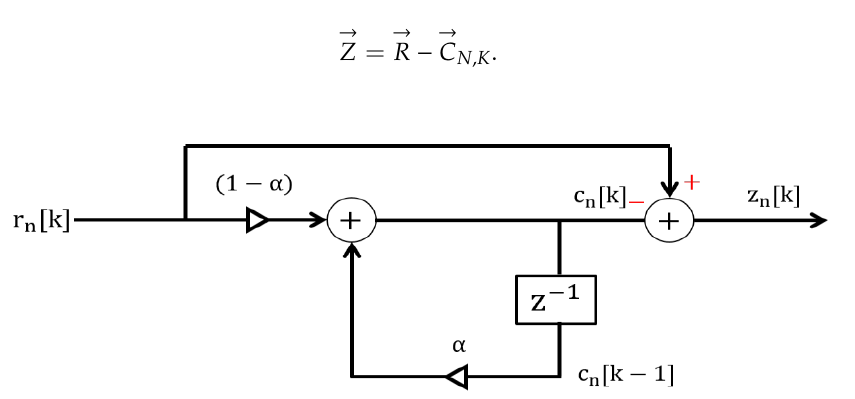
Figure 4. Clutter removal filter with a single-delayed feedback term.